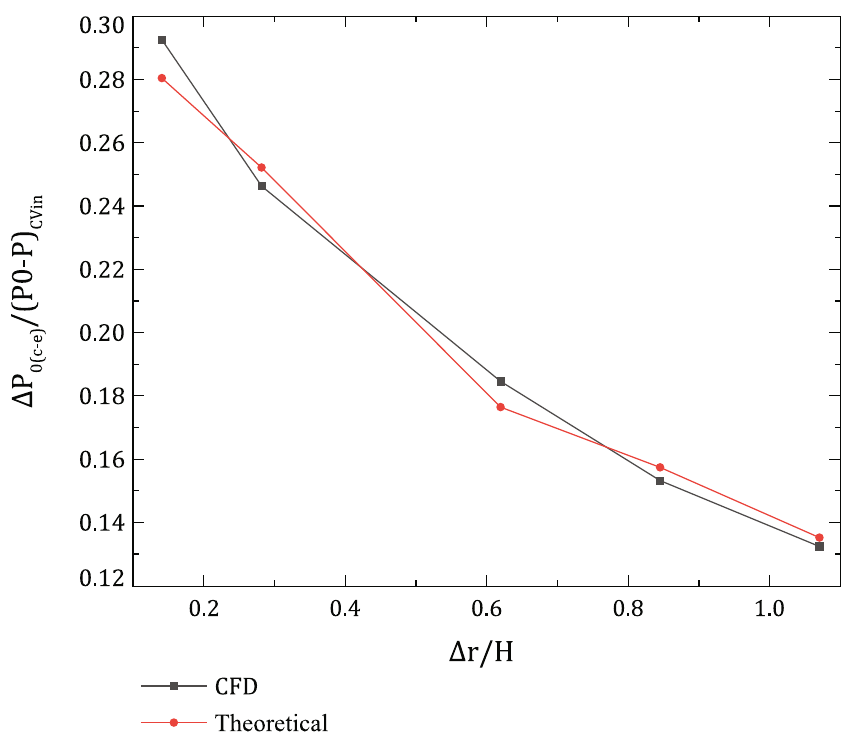
Figure 18: Comparison of results of theoretical model and CFD for SPL coe ffi cient in o ff -take duct with di ff ering radial height of plenum chamber.